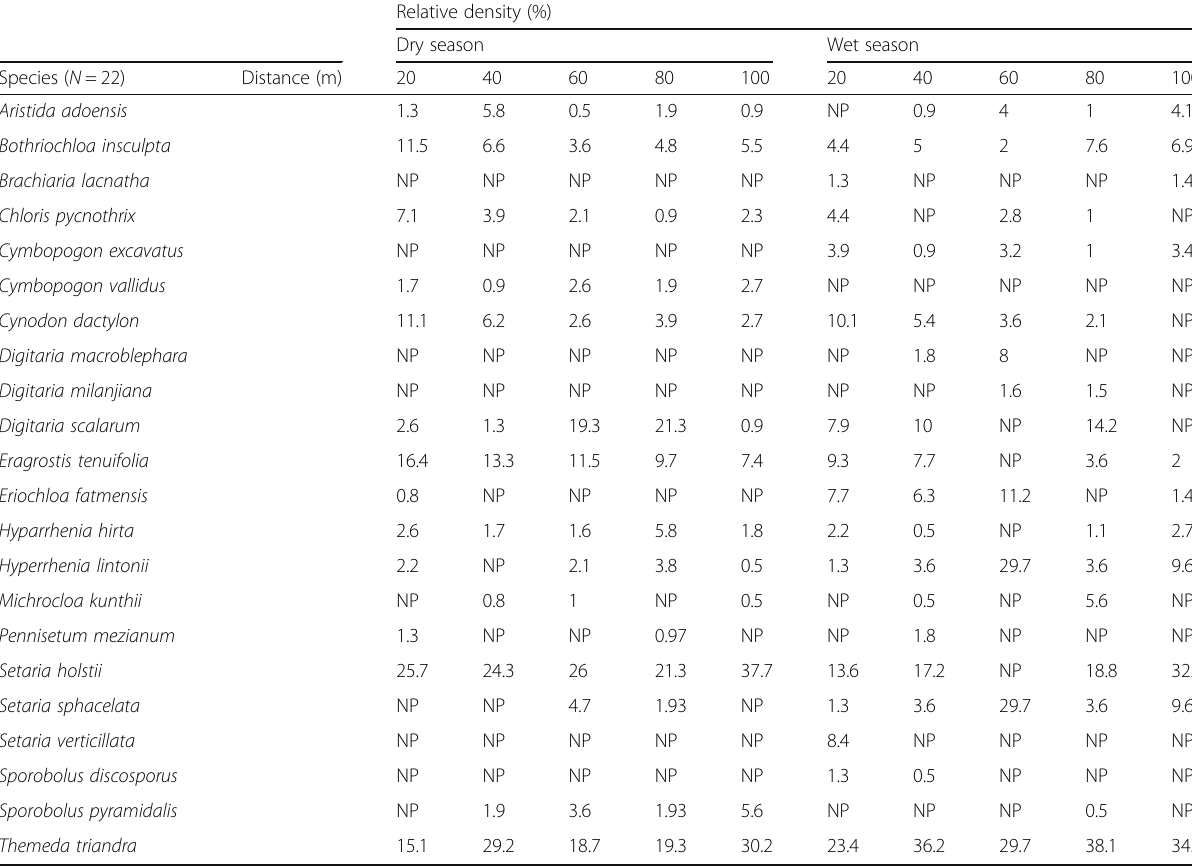
Table 1 Relative densities (%) of grass species at various piospheric distances Relative density